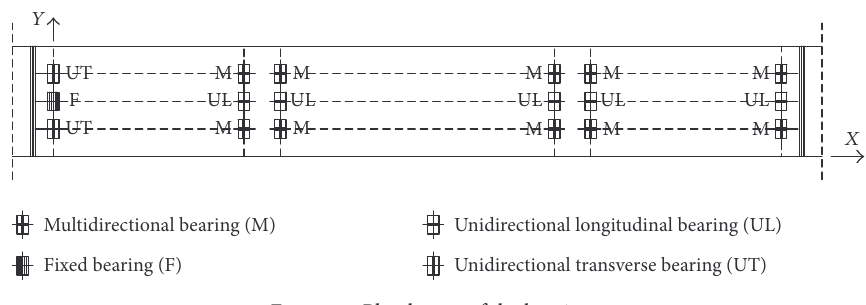
Figure 5: Plan layout of the bearings.